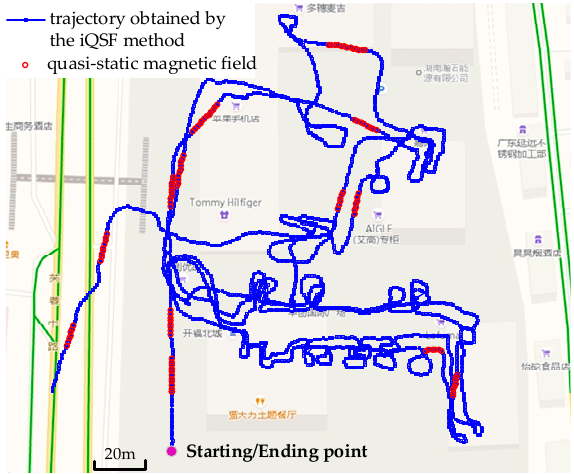
Figure 13. The detection results of quasi-static magnetic field using iQSF method. Sensors 2018 , 18, x FOR PEER REVIEW